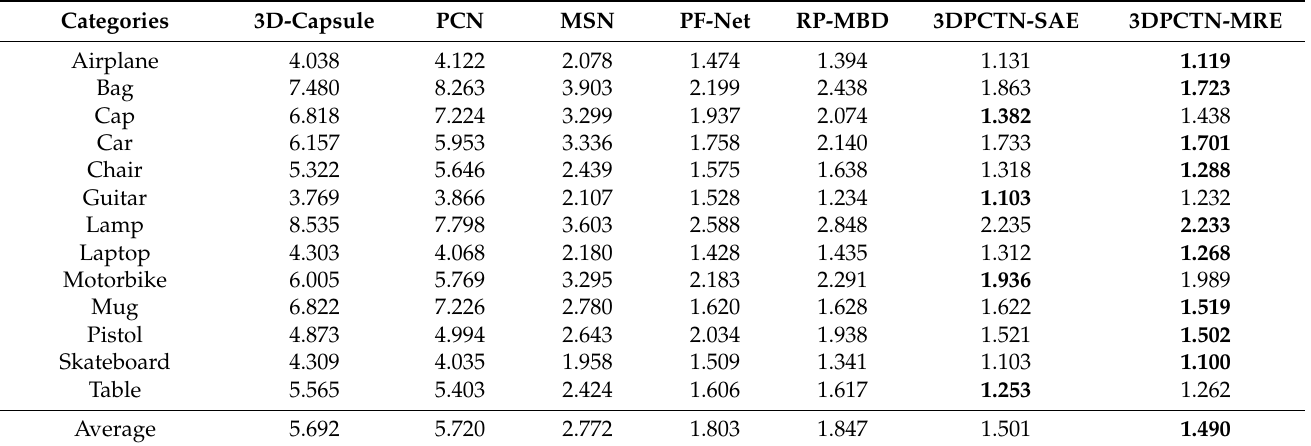
Table 2. Quantitative comparison between our methods and existing methods on ShapeNet-Part dataset using earth mover’s distance (EMD × 100) with 2048 points. The best results are highlighted in